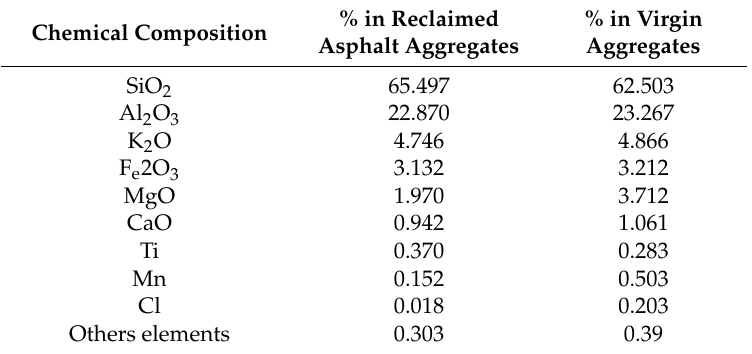
Table 3. Chemical composition of reclaimed asphalt aggregates and virgin